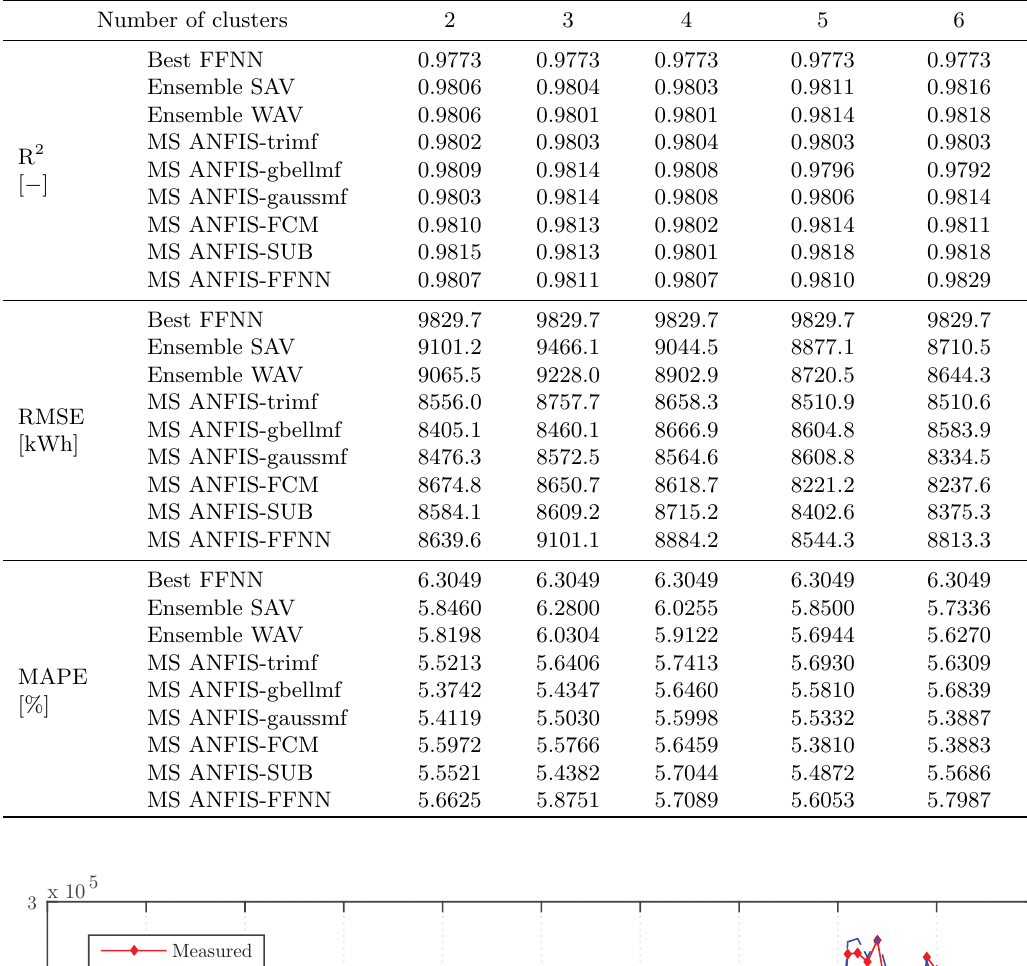
Table 2: Prediction indices for testing networks